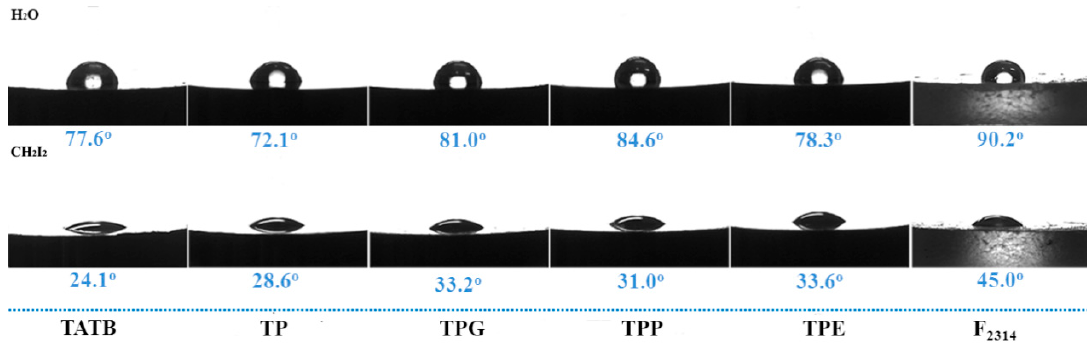
Figure 6. Contact angles using water and diiodomethane for different grafted TATB samples. Table 2. Contact angles and surface energies of different droplets on modified TATB and F 2314 pellets. Sample